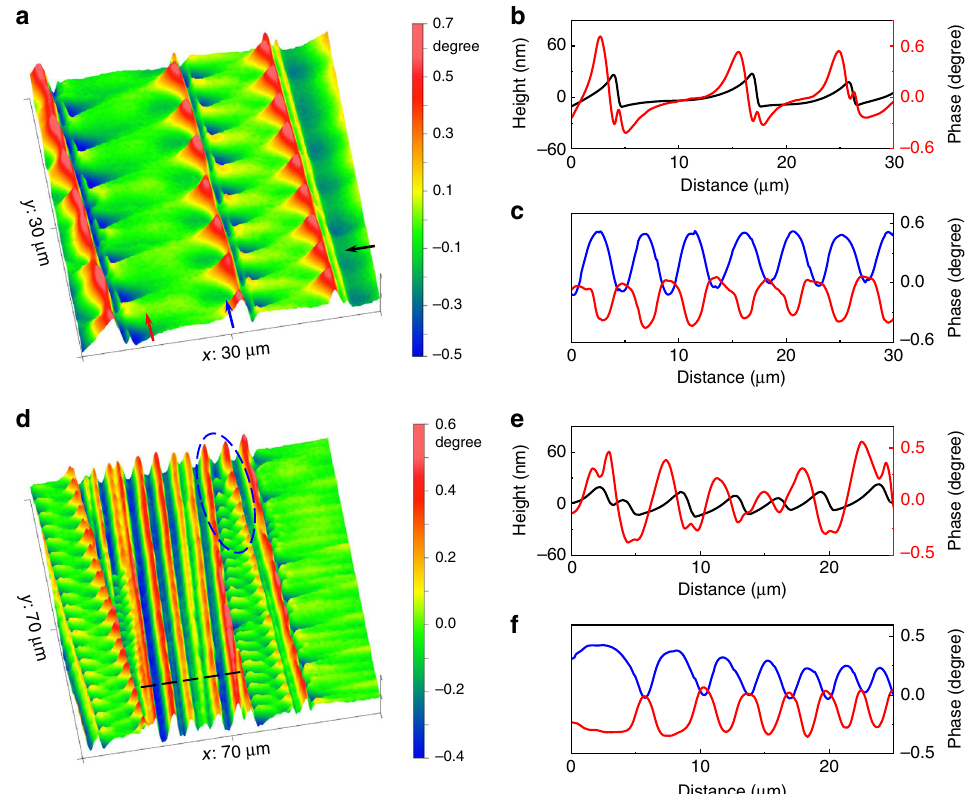
Fig. 4 Typical MFM micrographs of multiple shear bands. a MFM phase image of multiple shear bands. b Height and the corresponding MFM phase pro fi les along the path indicated by the black arrow in a . c MFM phase pro fi les along two adjacent shear bands indicated by the colored arrows in a . The magnetic domains between adjacent shear bands appear in pairs, resulting in domains of into-plane magnetization near one shear band correspond to domains out-of- plane magnetization near the other shear band. d MFM phase image of multiple shear bands with intersections. e Height and the corresponding MFM phase pro fi les along the line in d . f MFM phase pro fi les along two intersecting shear bands in the region marked by the blue ellipse in